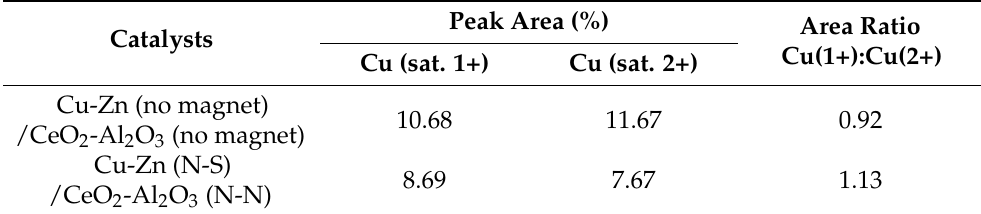
Table 3. Peak areas and area ratio of the satellite peaks of Cu 2p (1+) 3/2 and Cu 2p (2+) 3/2 determined by